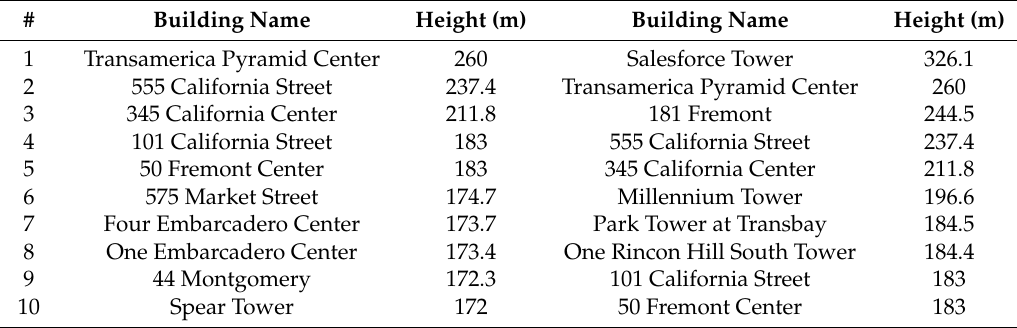
Figure 12. San Francisco in 2000 and 2020. Table 22. San Francisco’s 10 tallest skyscrapers in 2000 and 2020.